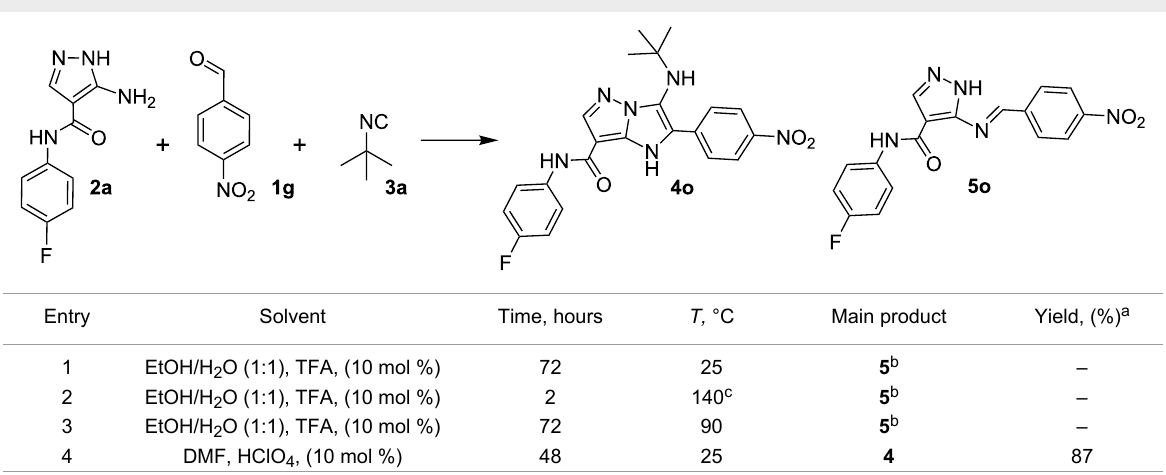
Table 3: Optimization of the reaction conditions for the synthesis of compound 4o